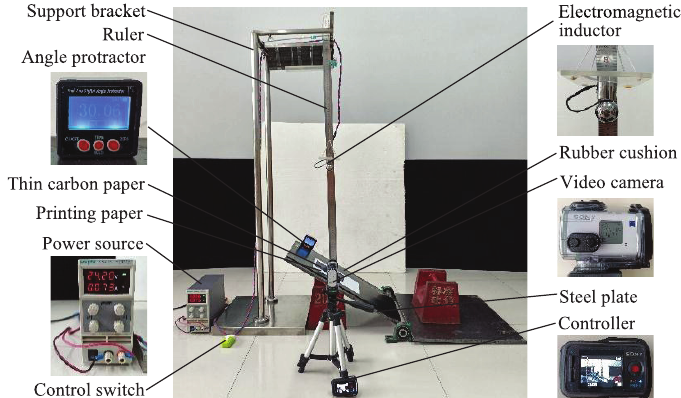
Fig. 2. Test device of sphere oblique impact with rubber cushion.